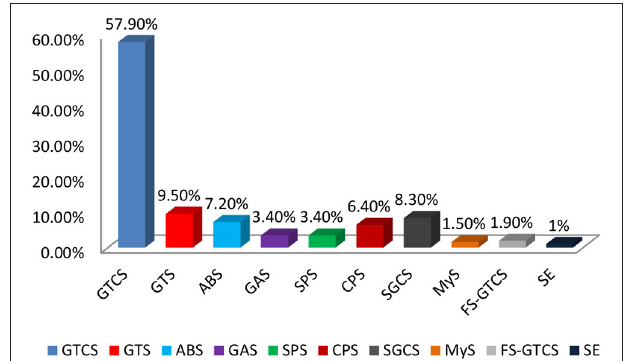
TABLE 2 | Demographic and clinical features of epileptic patients.